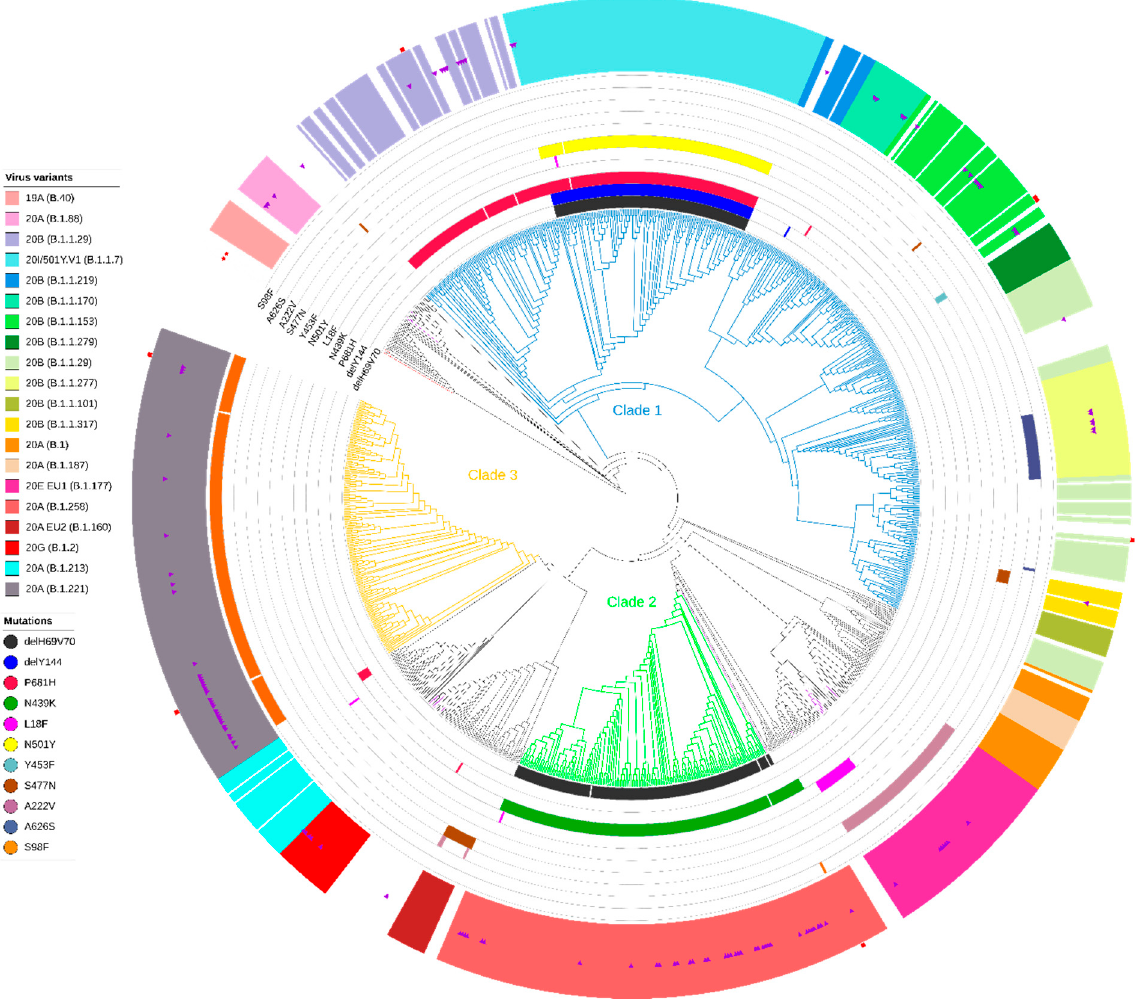
Figure 3. Maximum likelihood (ML) phylogeny of polish SARS-CoV-2 whole-genome sequences (n = 1106). Branches of the three main clades are colored in blue, green, and orange. Specific mutations in spike are highlighted: Δ H69/V70, Δ Y144, P681H, N439K, L18F, N501Y, Y453F, S477N, A222V, A626S, and S98F). Inner rings indicate the presence or absence of the deletion and amino acid variants. The multicolored outer ring shows the presence of the most common virus variants in Poland. The purple triangles mark the 122 sequences from the West Pomeranian region. The red stars indicate Wuhan reference sequences (GenBank accession no. MN908947.3 and GISAID accession no. EPI ISL406801). Polish sequences (n = 984) were obtained from the GISAID database (accessed 1 March 2021). Red squares indicate seven sequences that did not follow the clade-defining mutations pattern. Virus variants were assigned in Nextstrain (and PANGO lineage) classi- fication.